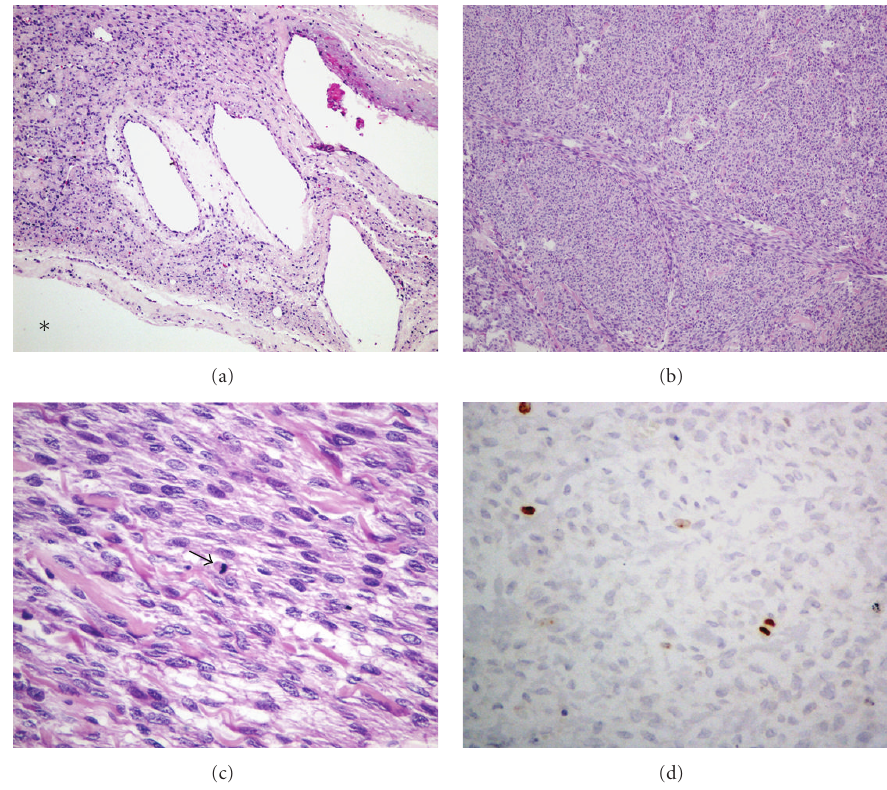
Figure 2: (a) Photomicrograph of the wall of the cystic area (asterisk inside the larger cavity) showing no epithelium lining and other similar, smaller cavities, with fibroma in the middle, with usual cell density (HE—100x); (b, c) and ( d) Representation of the solid area compatible with cellular fibroma, noting evident high cell density ((b) HE-100x), mild atypia ((c) HE—400x) and mitosis (arrow); (d) MIB-1 immunostaining (400x) showing sparse positive cells